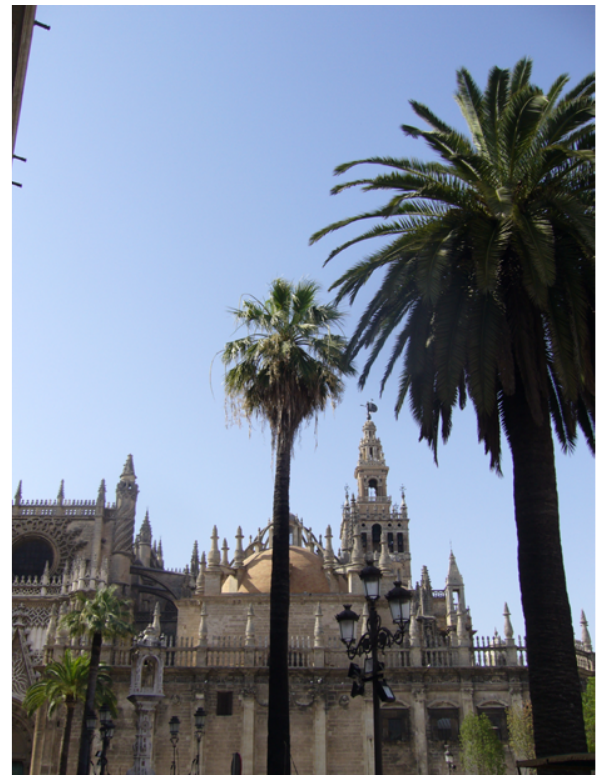
Figure 5: The Giralda in the background, with the cupola of the sacristy in the foreground, Seville Cathedral. Photo by